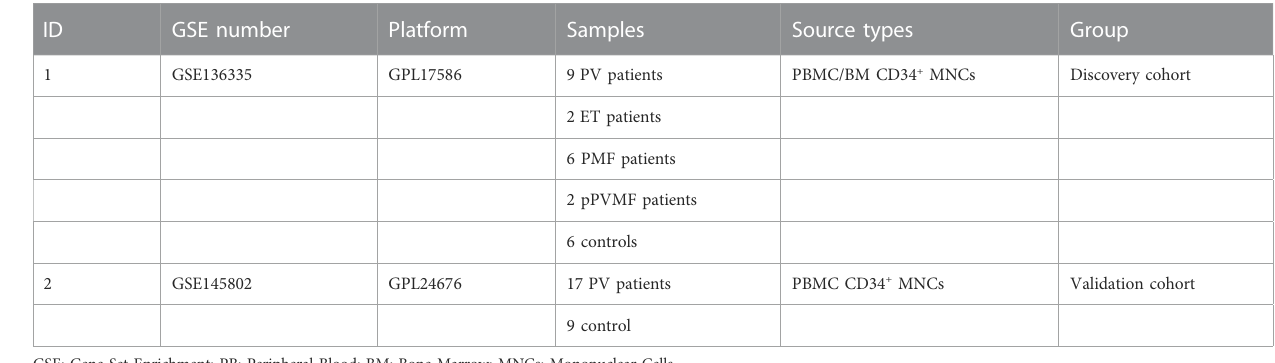
TABLE 1 Summary of GEO datasets involving MPN patients.